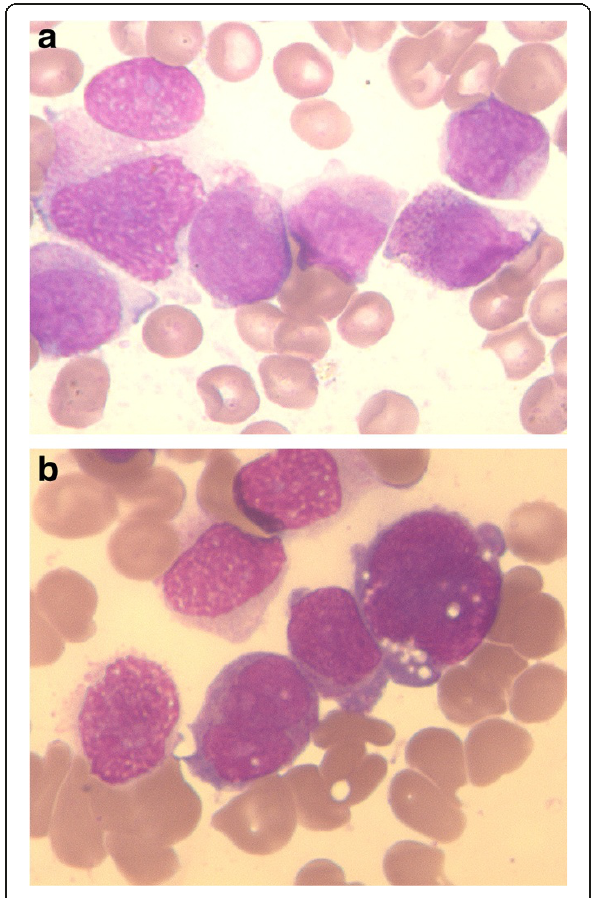
Figure 1 Bone marrow smears of cases of APL. A - classical morphology: the leukemic cells present a folded nucleus and a broad and hypergranular cytoplasm. Several cells present Auer rods (upper left and lower middle). B – variant morphology: the neoplastic cells present an oval or bilobated nucleus and few small granula in the less abundant cytoplasm. May-Grünwald-Giemsa.